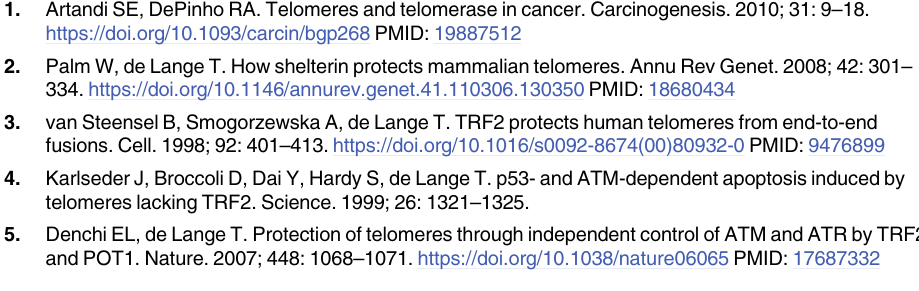
experiments (mean ± SD). Mann-Whitney U -test was used to compare RNA levels between each h and 0 h; � P < 0.05. S4 Fig. Absence of significant changes in telomeric binding of RNAPII after exposure to etoposide. ChIP–slot assays of telomeric and centromeric DNA with an anti-RNAPII antibody and IgG as a control were performed in HeLa cells incubated with etoposide at 100 μ M for the indicated times. DNA precipitates were slot-blotted and hybridized with telomeric and centro- meric probes. A. ChIP–slot assay using an anti-RNAPII (pS2) antibody. B. Quantification of ChIP–slot assays represented in A (mean ± SD; n = 3). C. ChIP–slot assay using an anti- RNAPII (pS5) antibody. D. Quantification of ChIP–slot assays represented in C (mean ± SD; n = 3). Student’s t -tests were used to compare differences in DNA levels between RNAPII- ChIP and IgG-ChIP; � P < 0.05 and ns indicates P � 0.05. S5 Fig. Stability of GAPDH , β -actin , and c-myc in etoposide-treated cells. HeLa cells incu- bated with DMSO (vehicle alone) or etoposide at 100 μ M for 24 h were treated with actino- mycin D at 5 μ g/mL for the indicated times. GAPDH , β -actin , and c-myc were measured by RT–qPCR, normalized against 18S rRNA, and compared with 0 h. Error bars are derived from three independent experiments (mean ± SD). Student’s t -test was used to compare dif- ferences in gene levels between etoposide- and DMSO-treated cells; � P < 0.05 and ns indi- cates P �